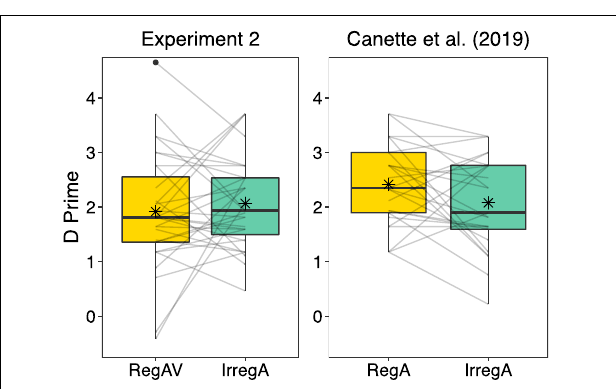
FIGURE 4 | Comparison of the current audio-visual (AV) experiment (Experiment 2; audio-visual regular primes: RegAV, auditory-only